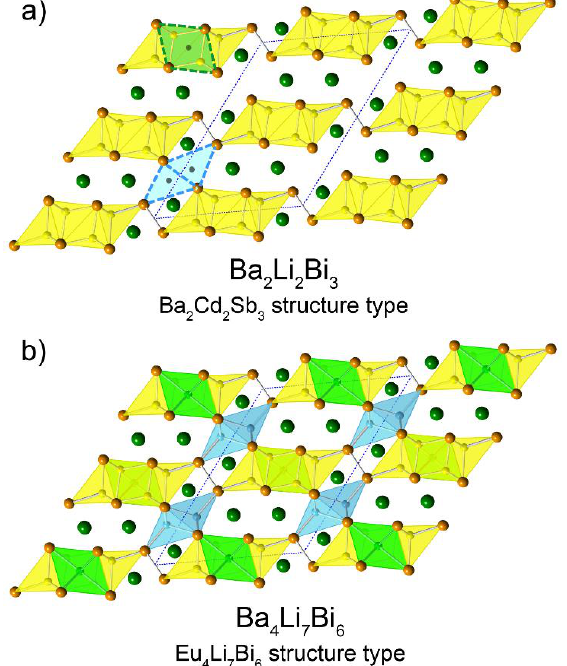
Figure 4. Schematic illustration of the structural relationship between the Ba 2 Cd 2 Sb 3 ( a ) and Eu 4 Li 7 Bi 6 ( b ) structure types, which both crystallize in the same monoclinic space group C 2/ m . The three “empty” holes in imaginary Ba 4 Li 4 Bi 6 (=Ba 2 Li 2 Bi 3 ) that can be filled with Li atoms to yield Ba 4 Li 7 Bi 6 are emphasized. Octahedral positions are in green, tetrahedral ones are in light-blue, in accordance with the color coding for the other figures.